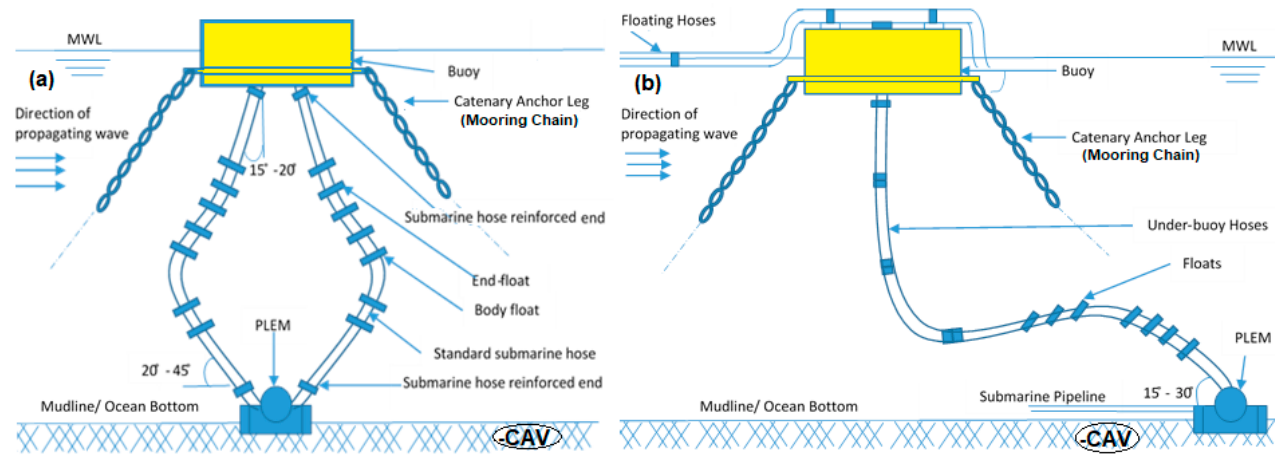
Figure 1. Sketch of loading and offloading operation on a CALM buoy with wave forces and boundary conditions, showing the ( a ) Chinese-lantern and ( b ) Lazy-S configurations.